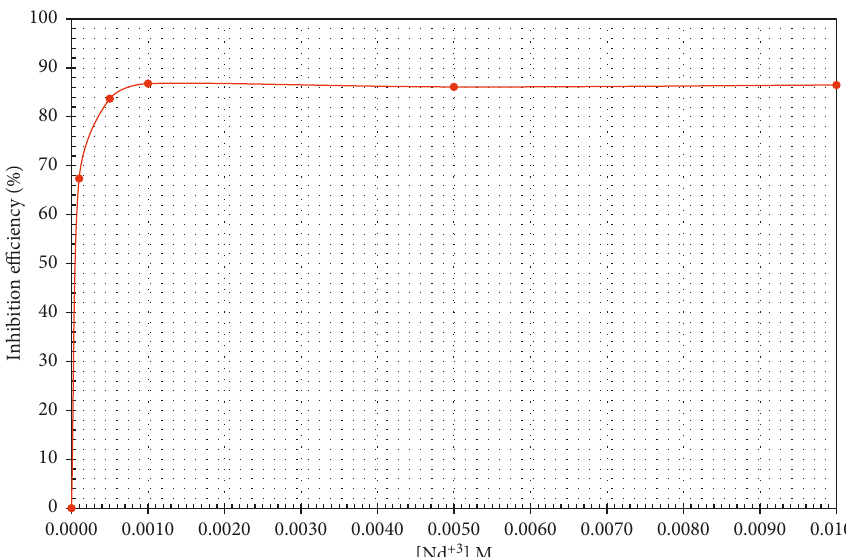
Figure 5: Effect of the concentration of Nd 3+ ions on the corrosion inhibition efficiency of API X70 steel in 3.5% NaCl